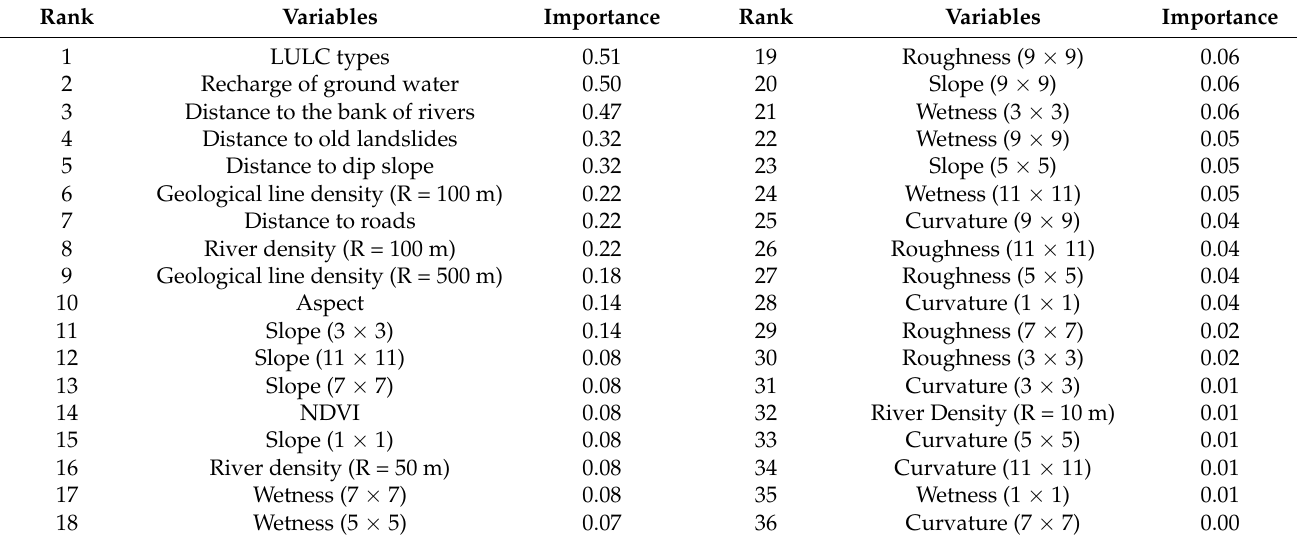
Table 2. Results of sensitivity analysis for evaluating variables used in RF modeling of